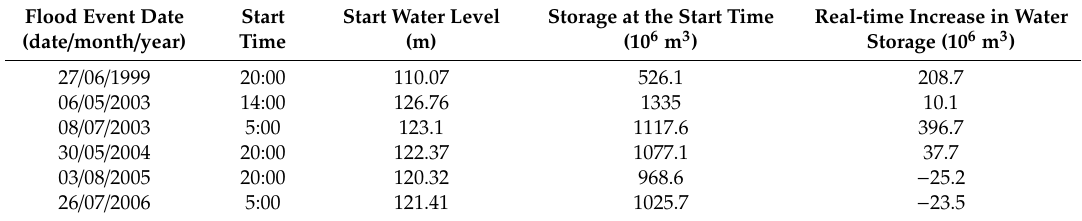
Table 7. Real-time increased water storage of flood